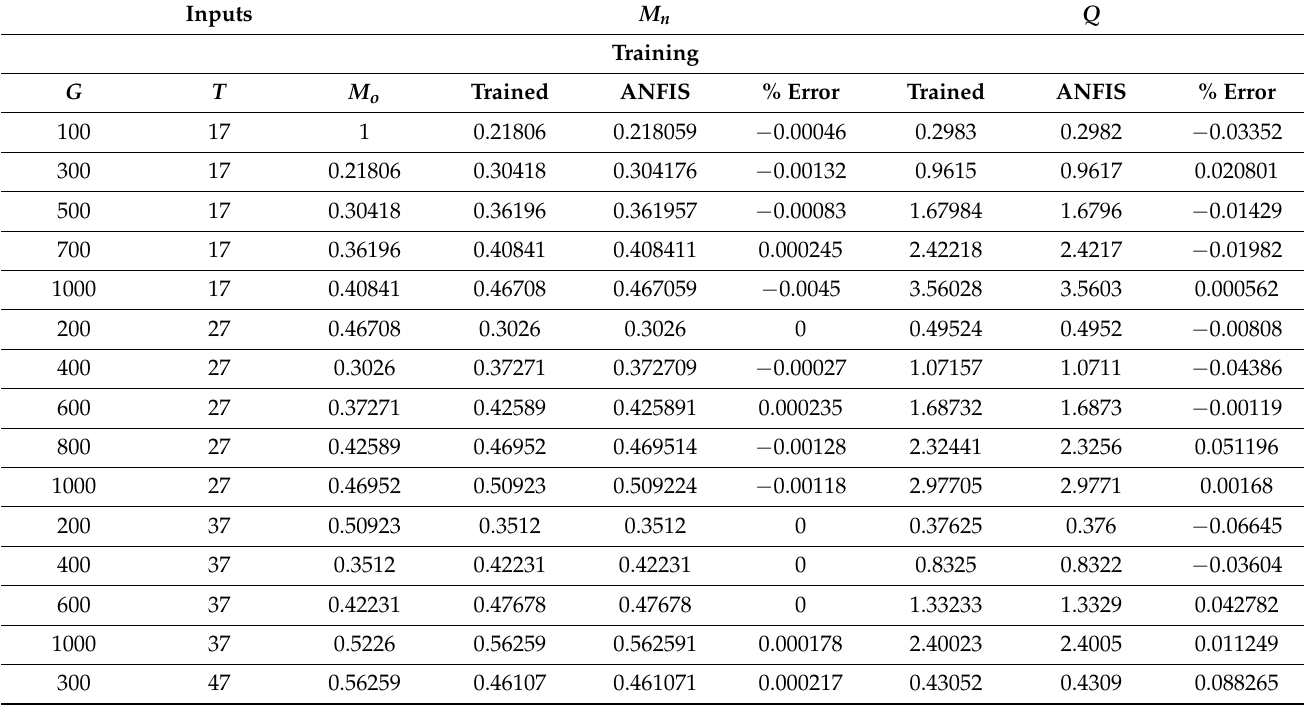
Table 1. Sample testing data sets for calculated and predicted by ANFIS